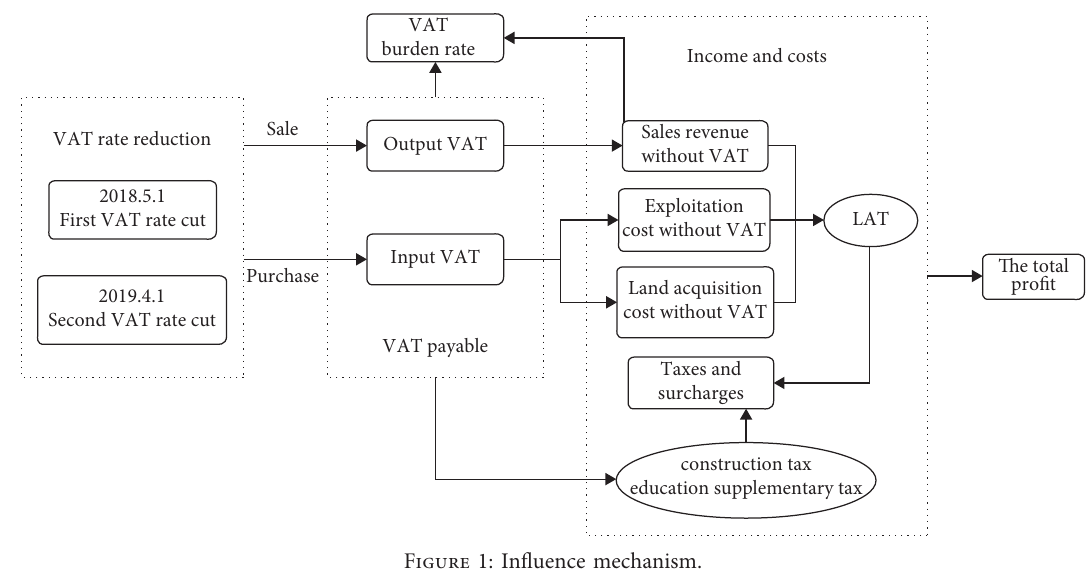
Figure 1: Influence